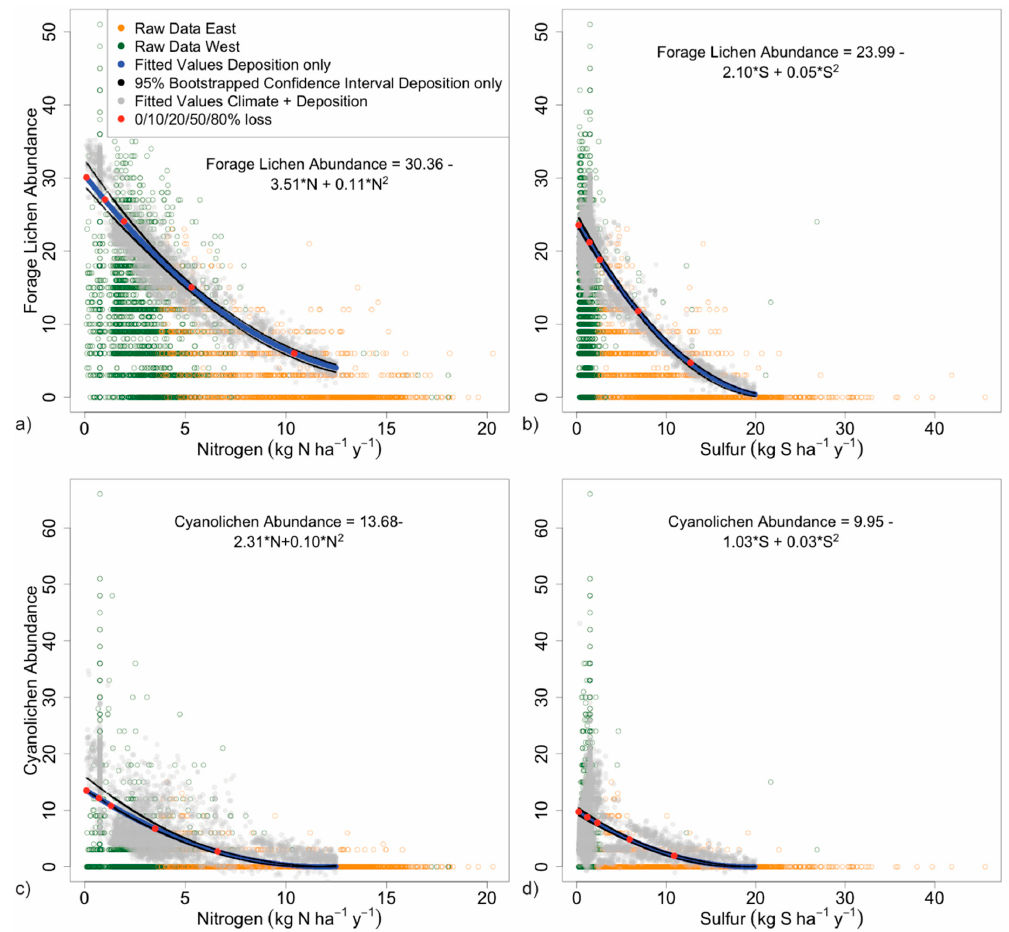
Figure 6. 90% quantile regression of deposition vs. forage lichen diversity and abundance for ( a ) N and ( b ) S, and of deposition vs. cyanolichen diversity and abundance for ( c ) N, and ( d ) S. Western and eastern sites are denoted by green and orange circles, respectively. Blue lines represent the fitted line for the 90% quantile predicted by the deposition only model; bootstrapped 95% confidence intervals are in black. Red dots indicate declines in the metric of 0, 10, 20, 50, and 80%. Fuzzed gray dots indicate 90% quantiles for the deposition + climate model.